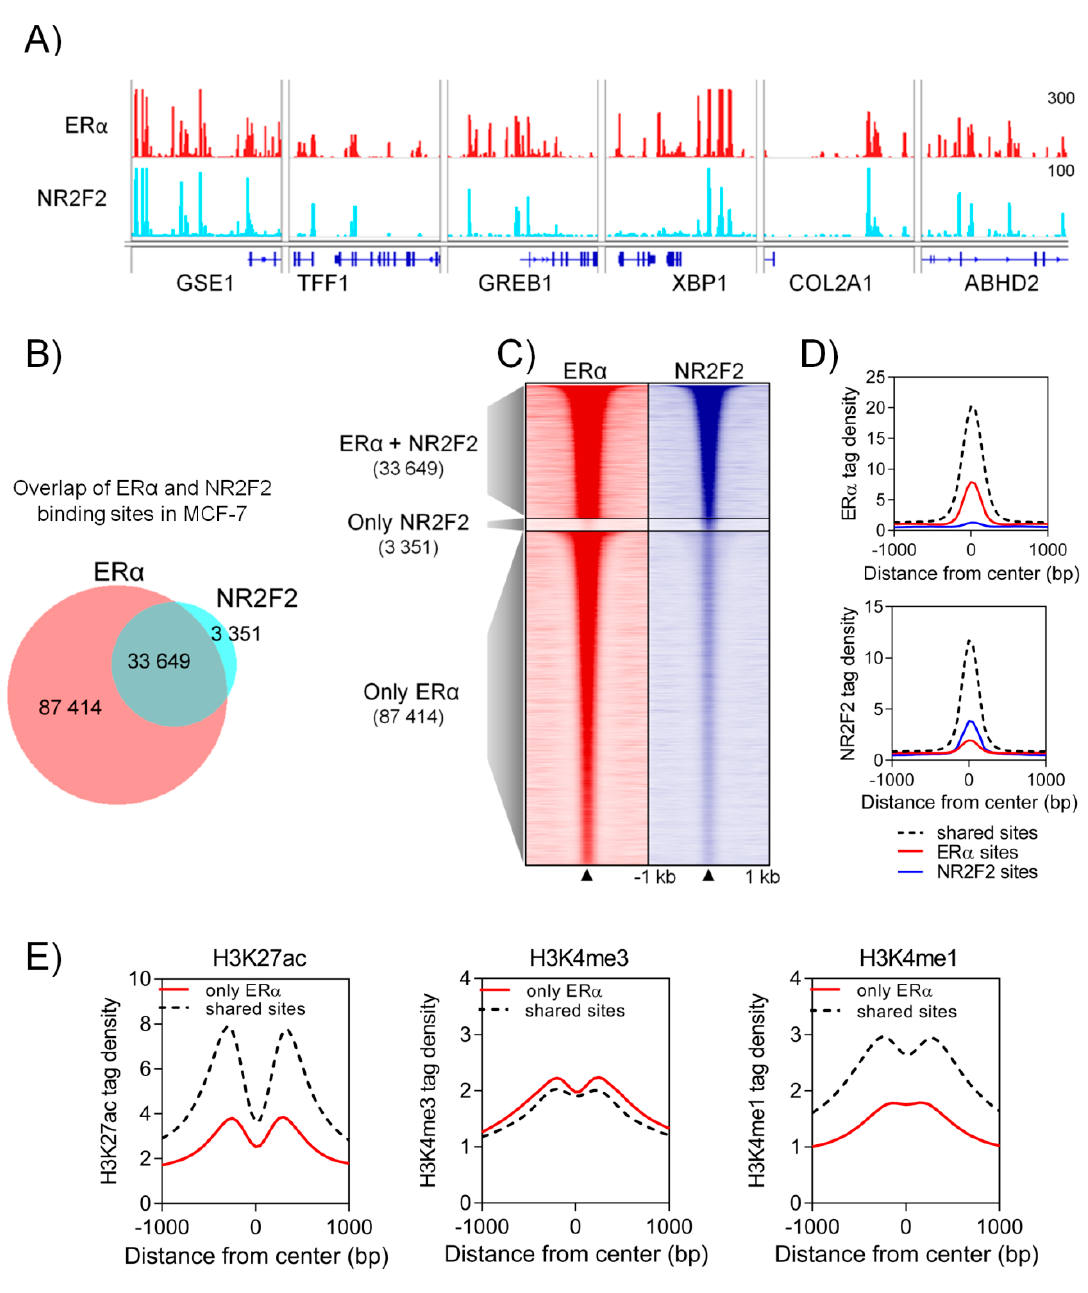
Figure 2. NR2F2 at ER α binding events in MCF-7 cells. ( A ) The Integrative Genomics Viewer IGV screenshot shows ER α and NR2F2 binding sites at ER α target genes. ( B ) Proportional Venn diagram and ( C ) heatmap represent the overlapping regions between ER α and NR2F2 binding sites. ( D ) Histograms show the ER α and NR2F2 tag density at shared and individual binding sites. ( E ) Histograms show the H3K27ac, H3K4me3 and H3K4me1 tag density at shared and individual ER α binding sites.